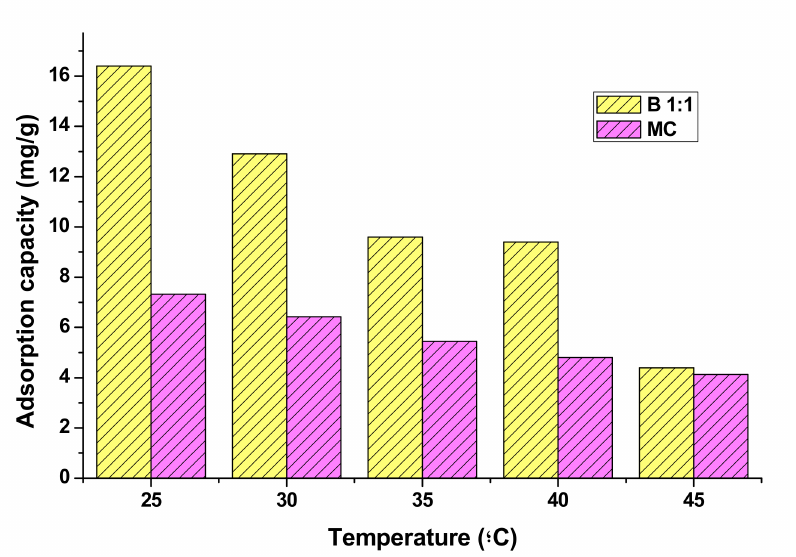
Figure 2. Effect of temperature on sulfate adsorption capacity using B 1:1 and MC.